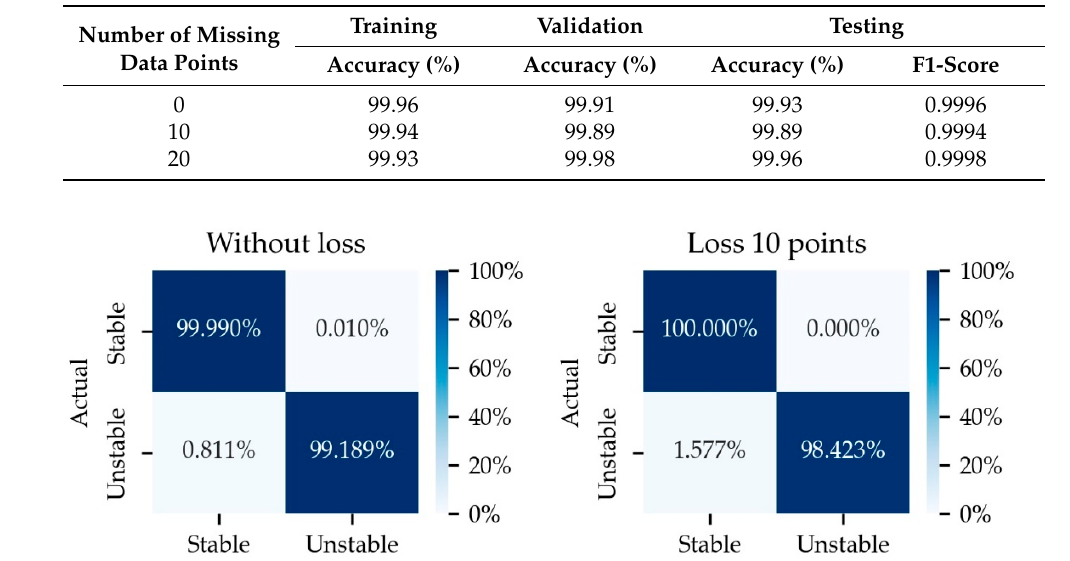
Table 7. Recapitulation of test results for the effect of data loss.